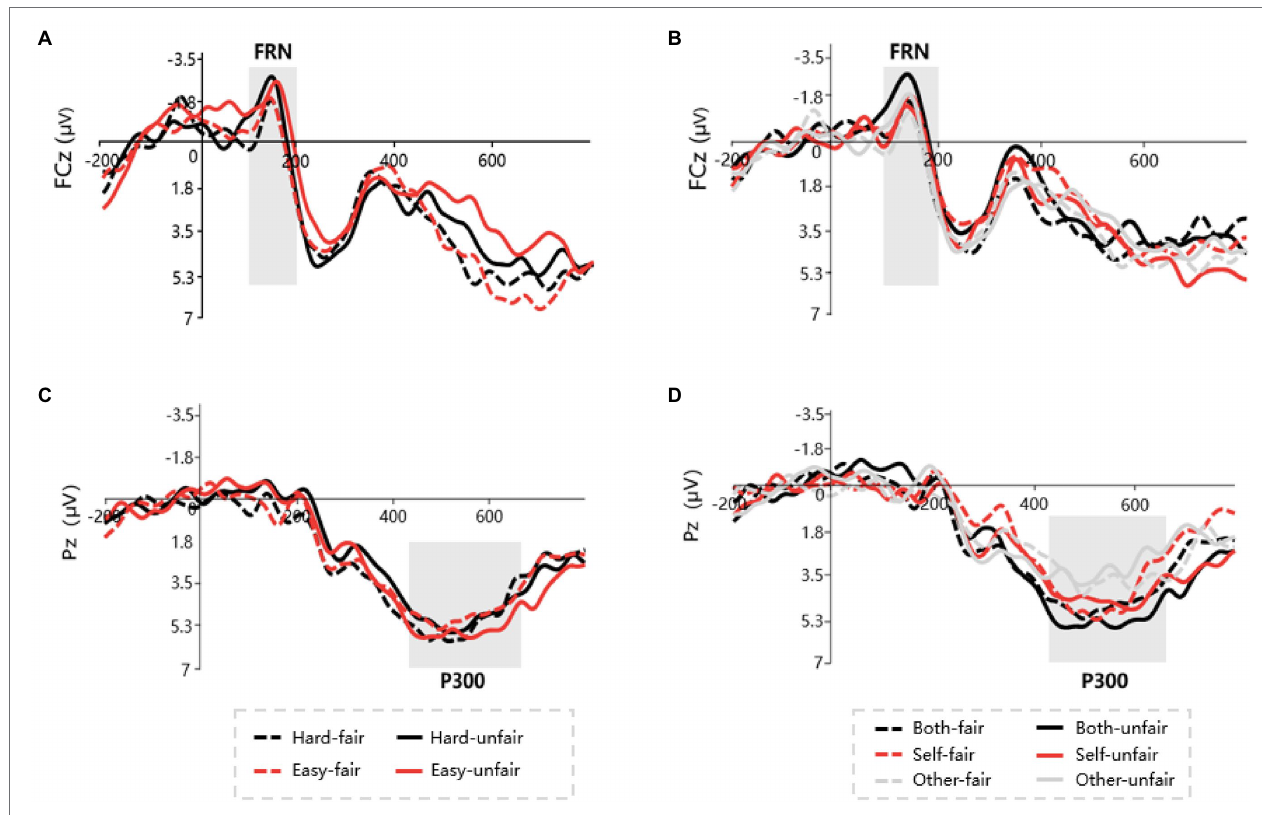
FIGURE 3 | ERP grand average waveforms. (A) FRN waveforms across difficulty and fairness conditions. (B) FRN waveforms across contribution and fairness conditions. (C) P300 waveforms across difficulty and fairness conditions. (D) P300 waveforms across contribution and fairness